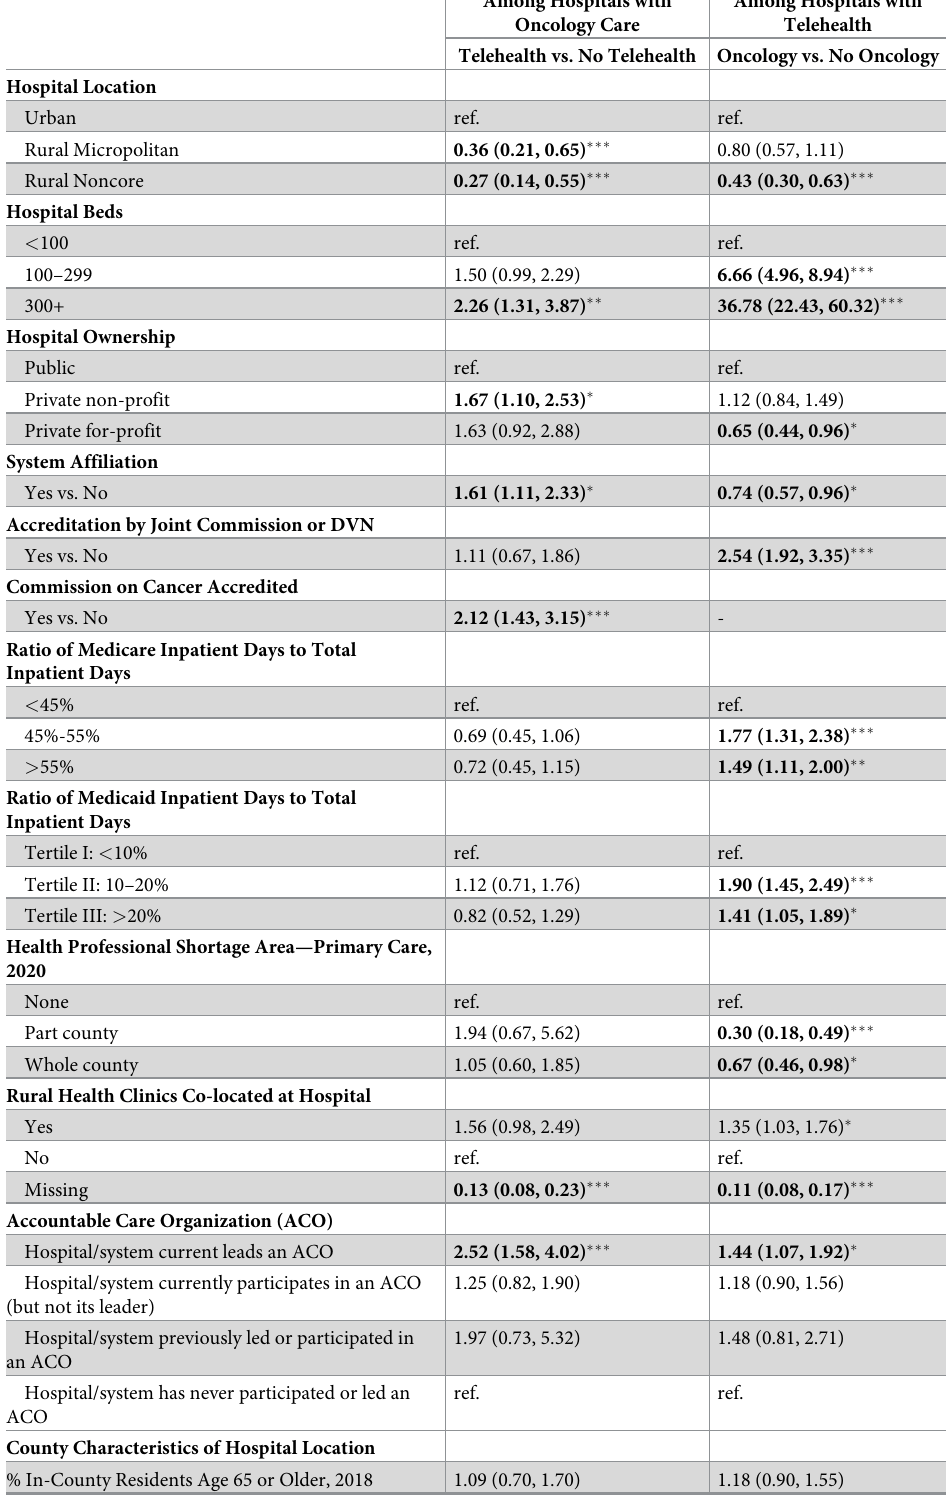
Table 3. Factors associated with availability of telehealth care in hospitals providing oncology services in 2019.